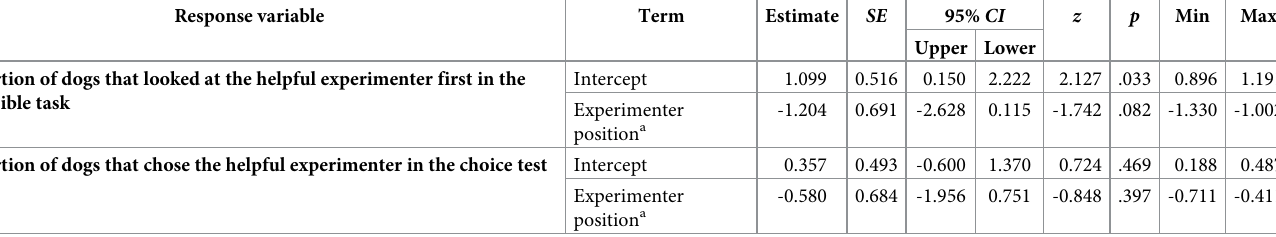
Table 2. Results of the full models.